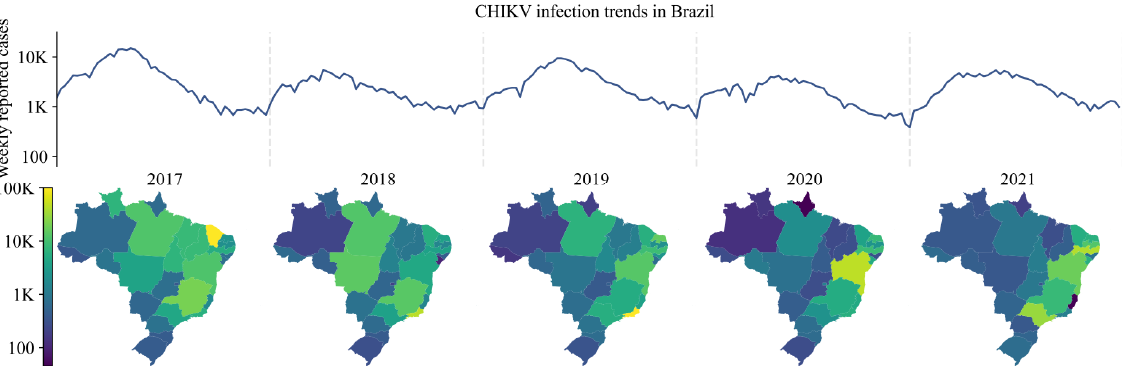
Figure 1. Weekly notifications of CHIKV infection 2017–2021, Brazil ( top ). State-level annual notifi- cations of CHIKV infection 2017–2021 ( bottom ). Please note log scale.